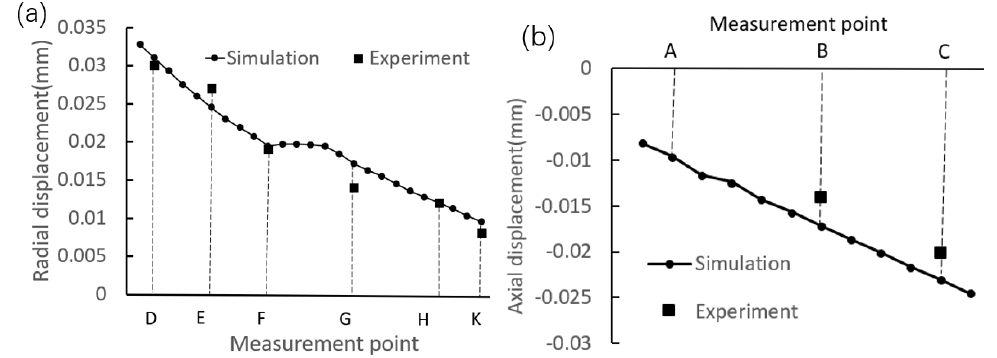
Figure 22. Displacement distributions along the generatrices. (a) Along the side generatrix. (b) Along the upper generatrix.